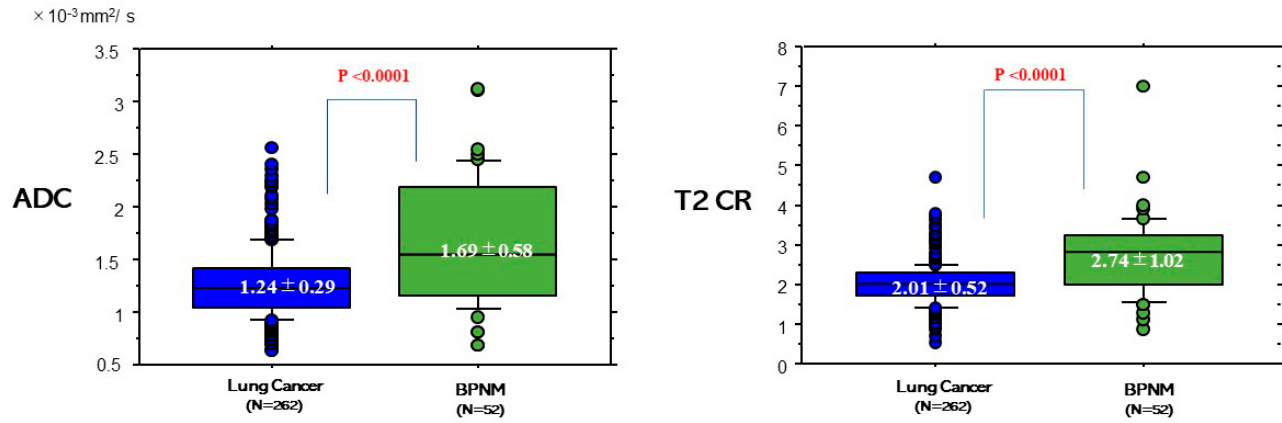
Figure 5. ADC and T2 Contrast ratio (CR) between lung cancers and BPNMs. The ADC (1.24 ± 0.29 × 10 − 3 mm 2 /s) of lung cancers was significantly lower than that (1.69 ± 0.58 × 10 − 3 mm 2 /s) of BPNMs ( p < 0.0001). T2 CR was the ratio of T2 signal intensity of the pulmonary nodule divided by T2 signal intensity of a rhomboid muscle. The T2 CR (2.01 ± 1.02) of lung cancers was significantly lower than that (2.74 ± 1.02) of BPNMs ( p < 0.0001).